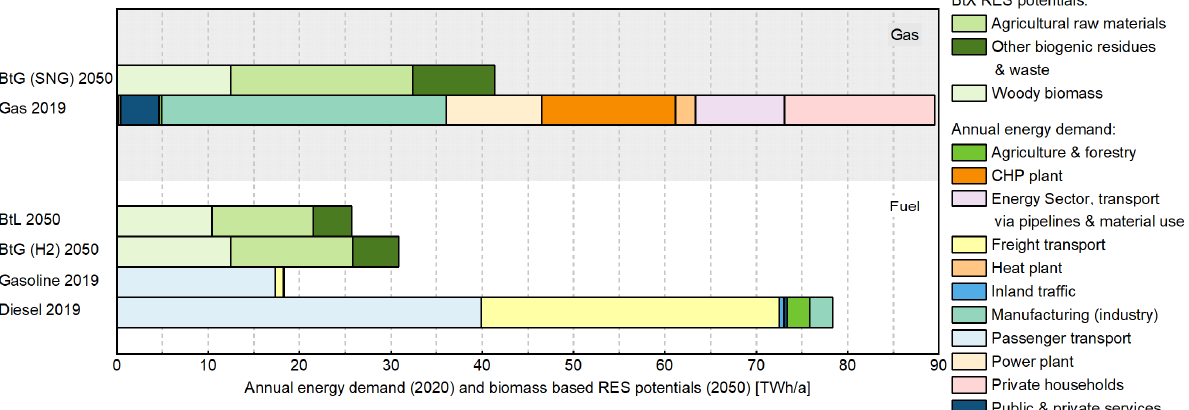
Figure 3. Central realizable potential regarding biomass-based synthetic gas and fuel products produced in CECs within the year 2050 compared with the current annual energy demand of natural gas, diesel, and gasoline in Austria.